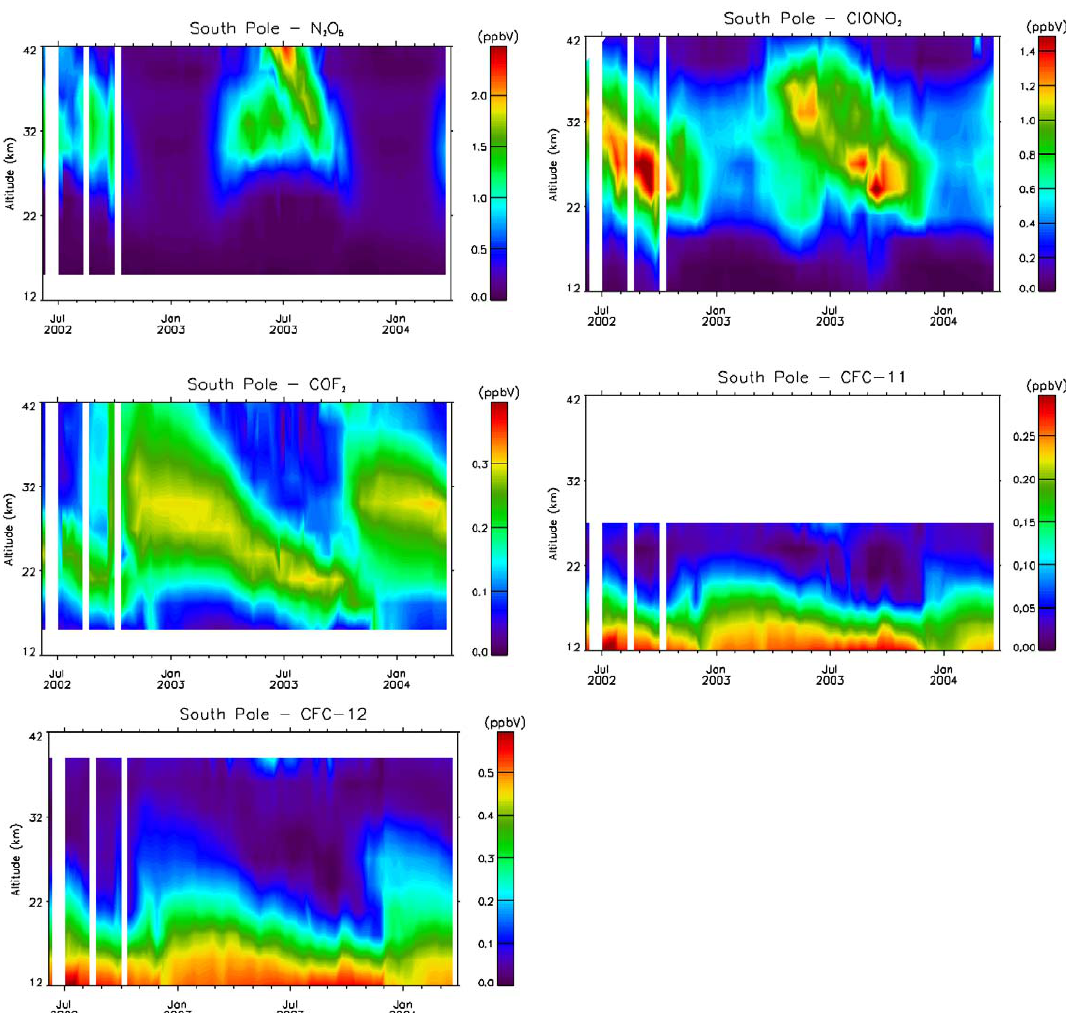
Fig. 16. Time series of 10-days means for the minor species N 2 O 5 , ClONO 2 , COF 2 , CFC-11 and CFC-12 in the Antarctic region (65 ◦ S– 90 ◦ S) mapped as a function of altitude and acquisition time.